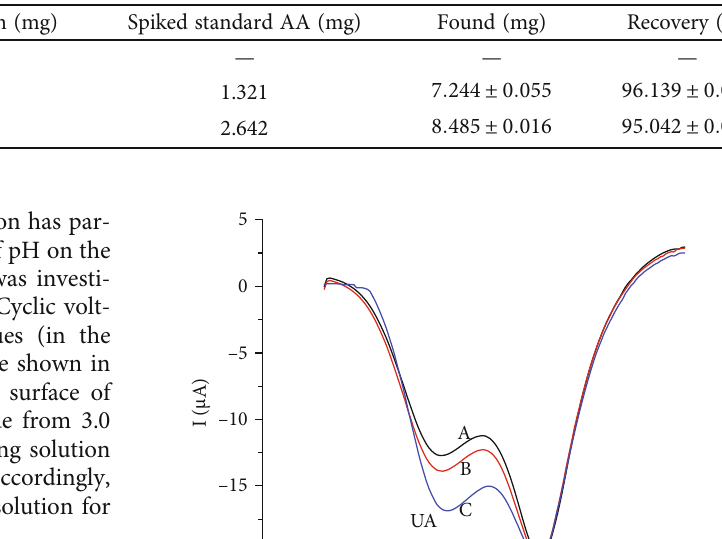
Table 2: Summary of recovery results of AA in Karishewa cabbage extract sample.